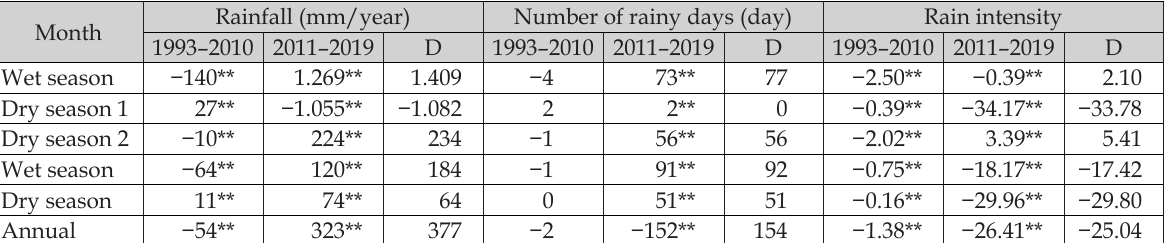
Table 4. Trends of changes in rainfall, number of rainy days and rain intensity in the Sanenrejo sub-watershed